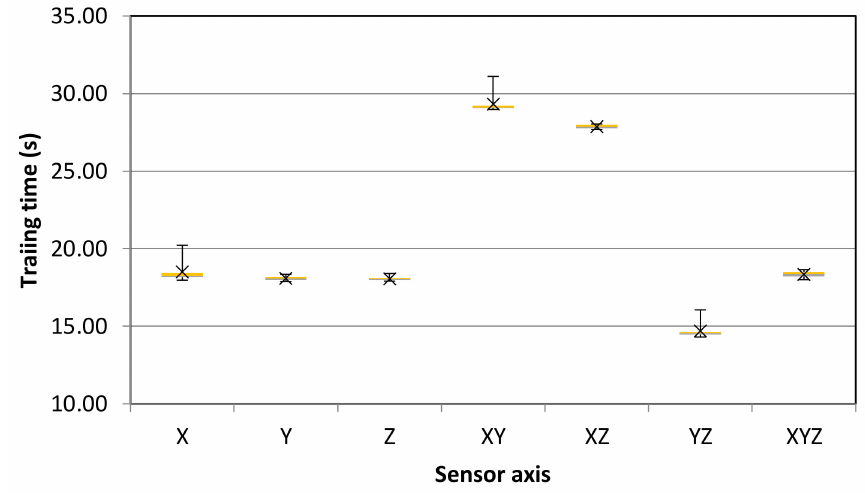
Figure 21. Box plot of ‘training time’ for all sensor axis of the accelerometer. The boxplot is divided into four quartiles, namely 1st, 2nd, 3rd, and 4th quar- tiles. The 1st, 2nd, 3rd, and 4th quartiles show a range data distribution of 0–25%, 25–50%, 50–75%, and 75–100%, respectively. The grey and yellow color in the boxplot of Figures 21–28. indicates the second, and third quartile, respectively. A wider box in the boxplot shows more distribution of